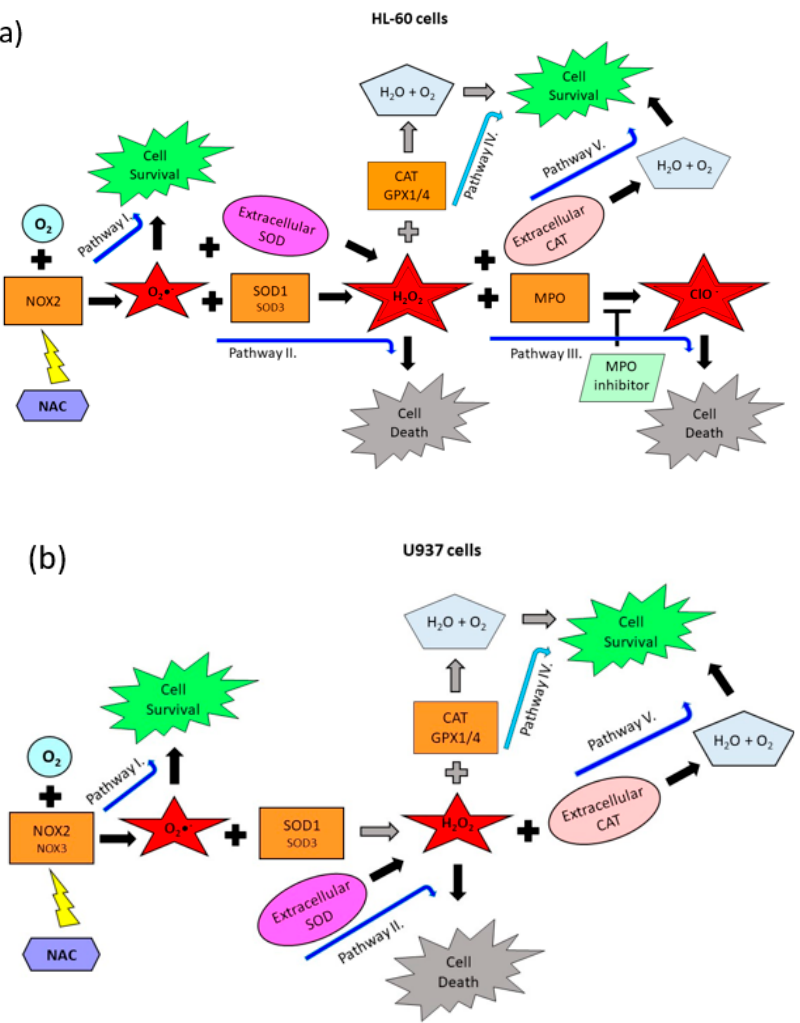
Figure 6. Identification of genes that are responsible for ROS production and their contribution to cell death induction. ( a ) Proposed scheme for HL-60 cells. Massive production of O 2 • − by NOX2 was not sufficient to induce cell death (Pathway I). Higher expression of SOD1 and SOD3 in HL-60 cells led to the induction of cell death (Pathway II). Inherent expression of CAT, GPX1, and GPX4 failed to prevent H 2 O 2 -induced cell death (Pathway IV). Conversion of H 2 O 2 to ClO − by inherent MPO led to the cell death induction (Pathway III). Extracellular SOD increased the number of dying cells (it strengthens the Pathway II and III). Extracellular CAT completely prevented cell death (Pathway V) ( b ) Proposed scheme for U937 cells. Elevated production of O 2 • − by NOX2(3) was not sufficient to induce cell death (Pathway I). Either lower expression of SOD1 and SOD3 in U937 cells failed to induce cell death (Pathway II) or inherent expression of CAT , GPX4 , and GPX4 failed to